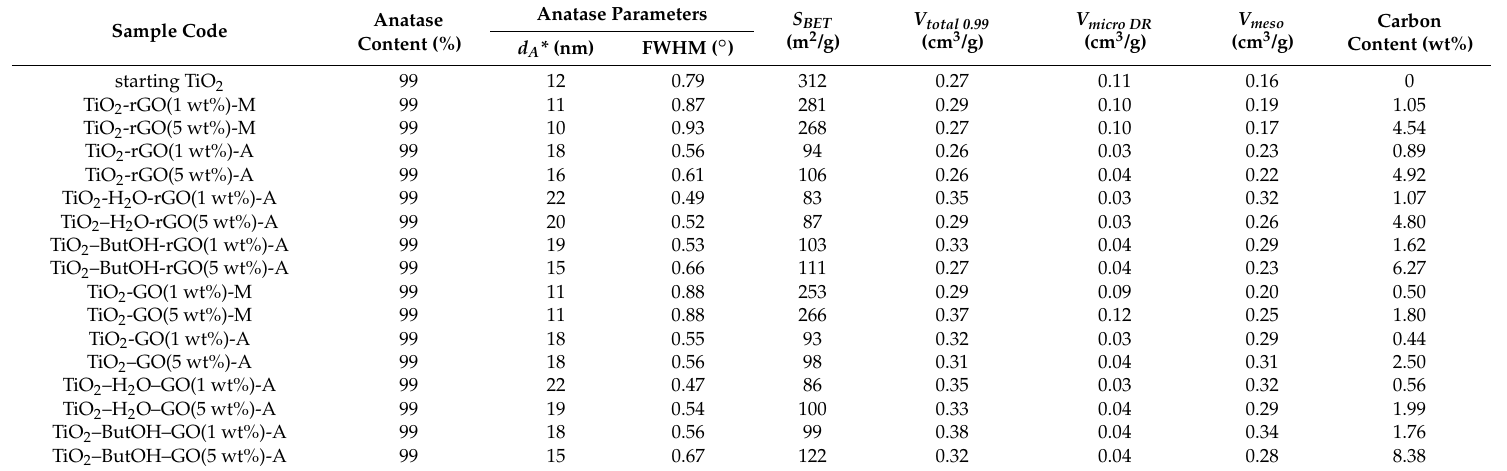
Table 1. The physicochemical properties of TiO 2 -GO and TiO 2 -rGO